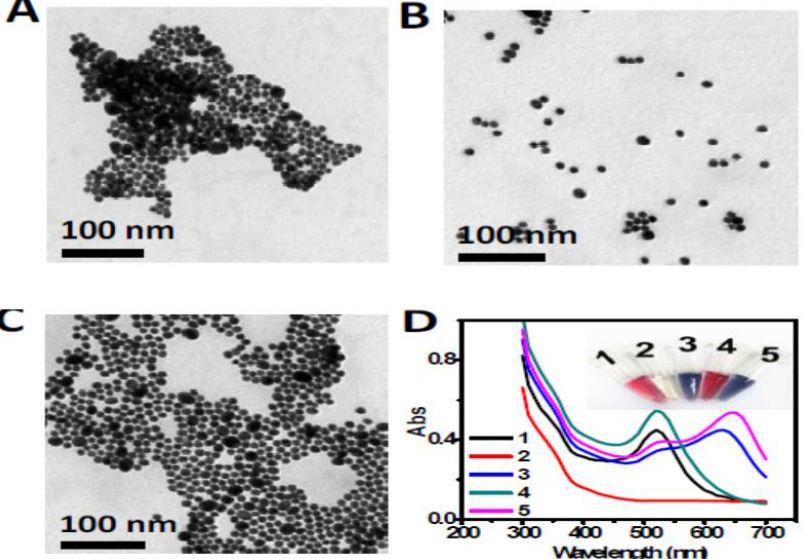
Fig. 7. TEM of different systems: (A) AuNP/CDs composite; (B) AuNP/CDs composite in presence of GSH; (C) AuNP/CDs composite in presence of GSH and Hg 2+ ; (D) UV-Vis spectra of the corresponding of different systems: 1-AuNP, 2-CDs, 3-A, 4-B, 5-C. Inset image is colorimetric response. Reprinted with permission from ref. 75. Copy right 2012 Royal Society of